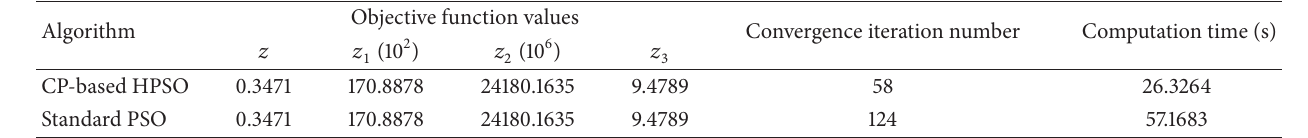
Table 13: Comparison results between CP-based HPSO and standard